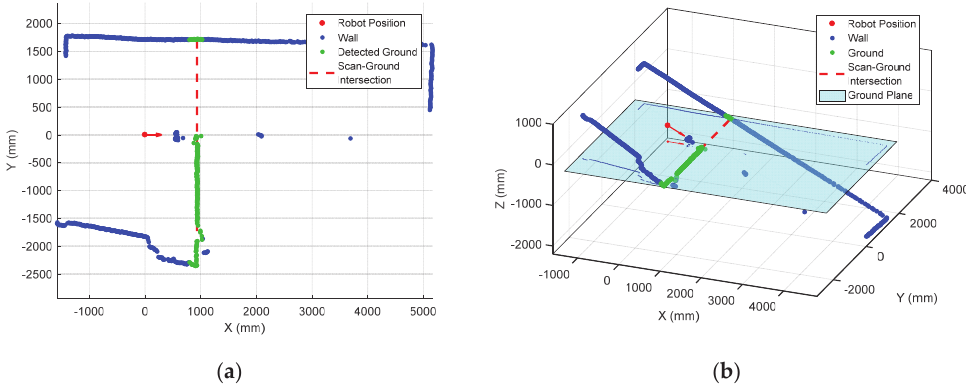
Figure 8. Experiment in front of a stairs going down: ( a ) raw scan data, ( b ) 3D representation. Distance points classified as ground (green), expected location of the ground (dotted red line).